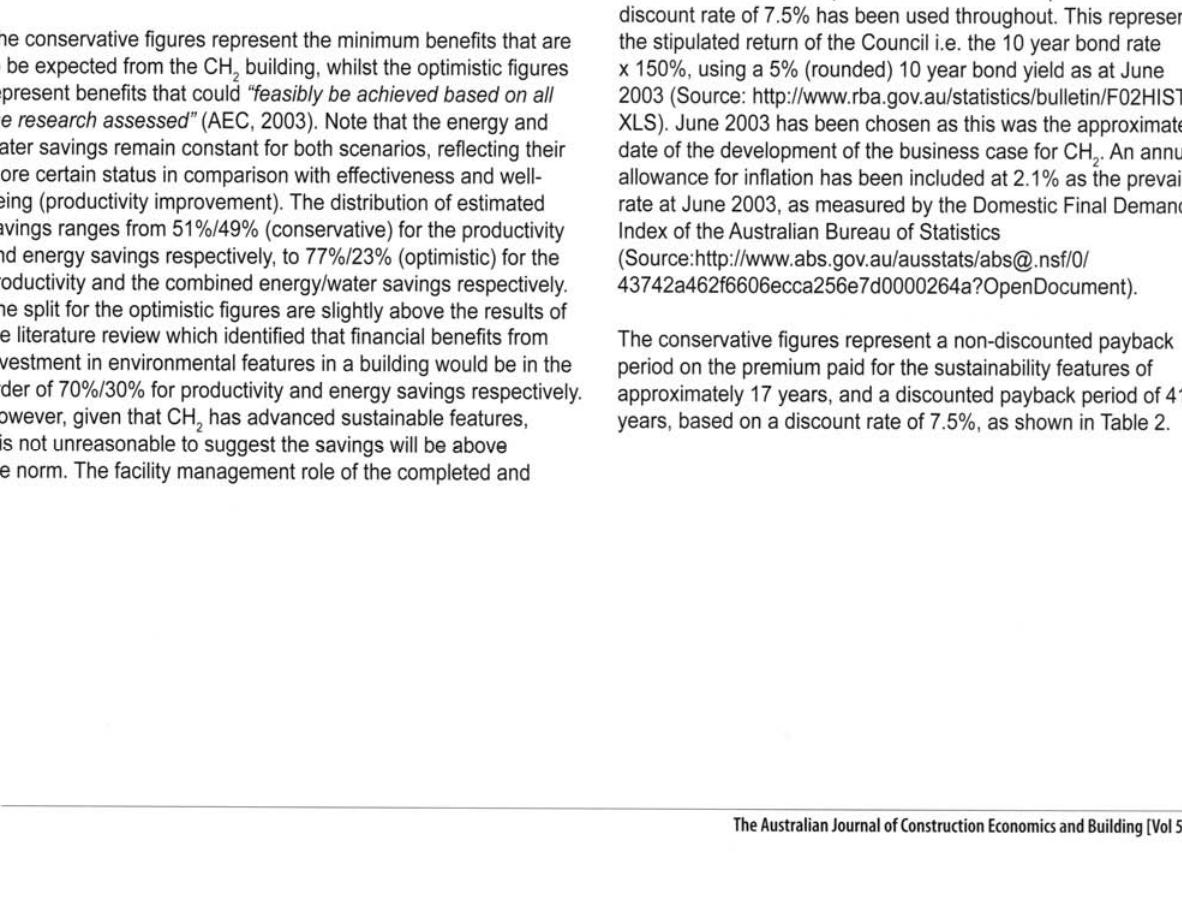
Table 1: Estimated Savings for CH